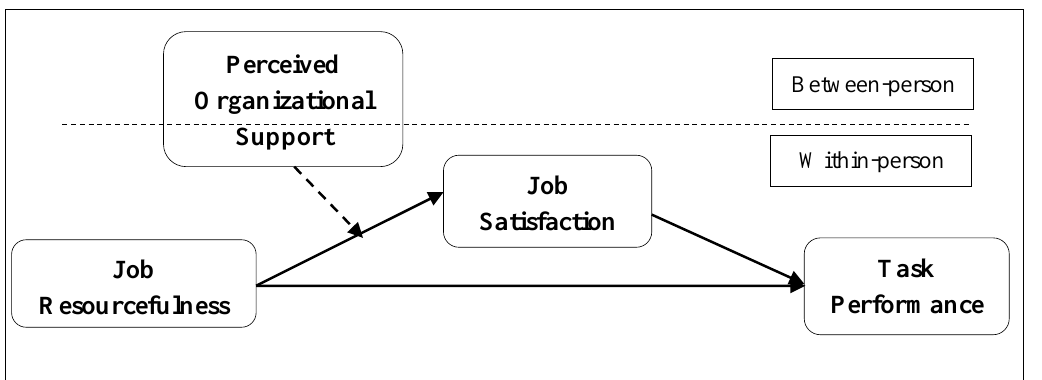
Figure.1. Theoretical